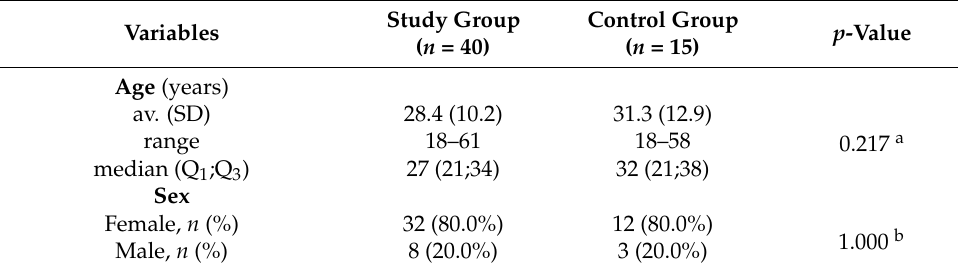
Table 4. Comparison of age and sex between the examined groups.